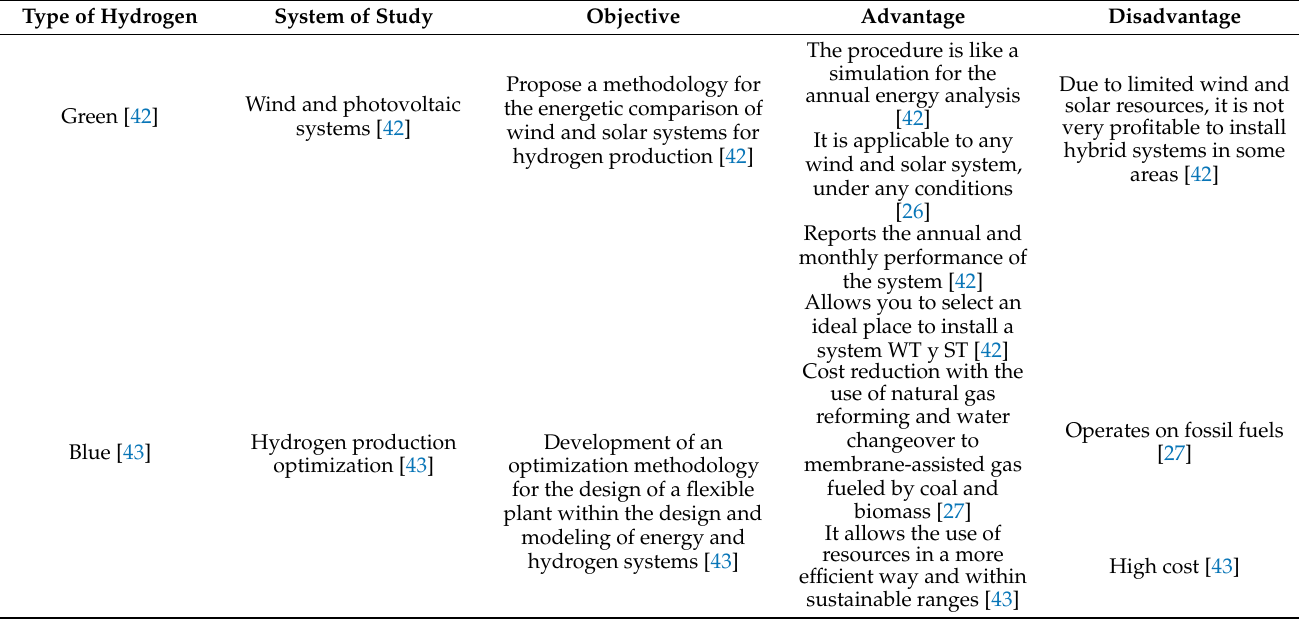
Table 6. Advantages and disadvantages of green and blue